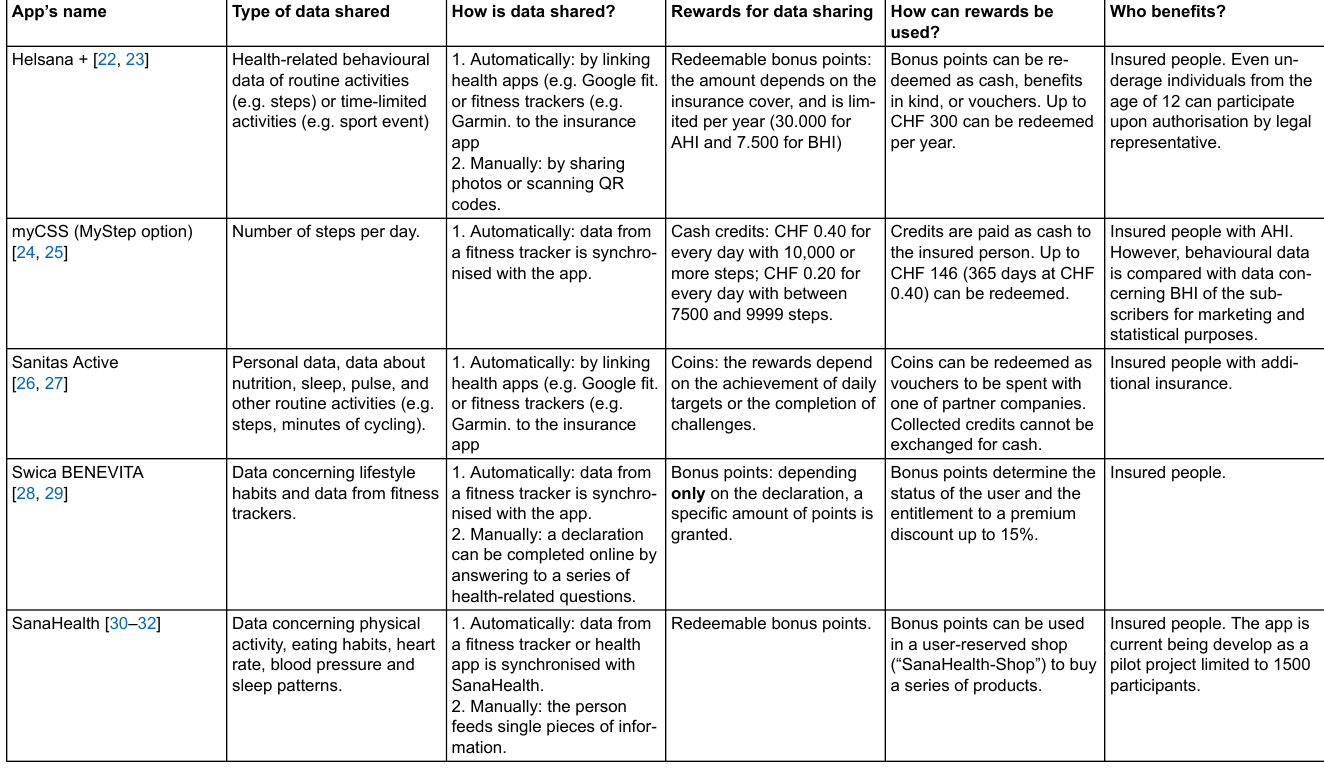
Table 1: Insurers’ data-sharing apps in Switzerland. App’s name Type of data